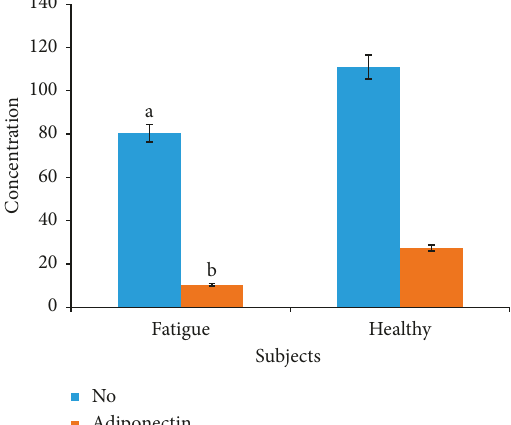
Figure 3: Differences in the levels of nitric oxide (NO) and adiponectin biomarkers markers of healthy and fatigued mature and older adults. Data expressed as means SD. In cases with fatigue, the data showed a significant reduction in the levels of both nitric oxide and adiponectin with an estimated R 0.245, a P 0.01 for nitric oxide (NO), and R (cid:31) (cid:31) ± Table 2: Correlation coefficients analysis between the levels of nitric oxide (NO), adiponectin, adiposity, diabetic markers, and physical activity status based on the scores of fatigue and cognitive abilities in normal and fatigued older adults ( n Parameters